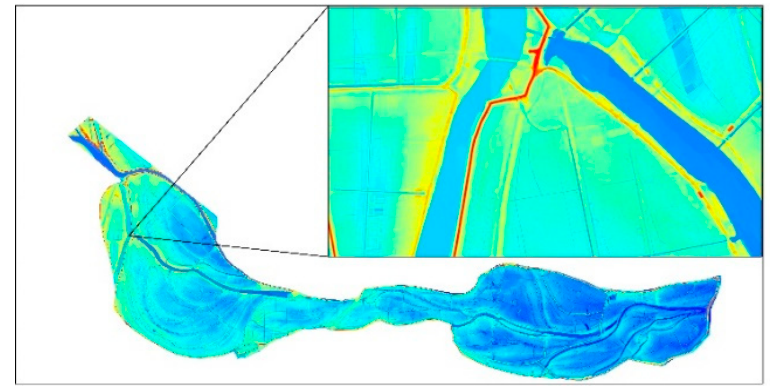
Figure 2. Example of airborne light detection and ranging (LiDAR) point cloud data.